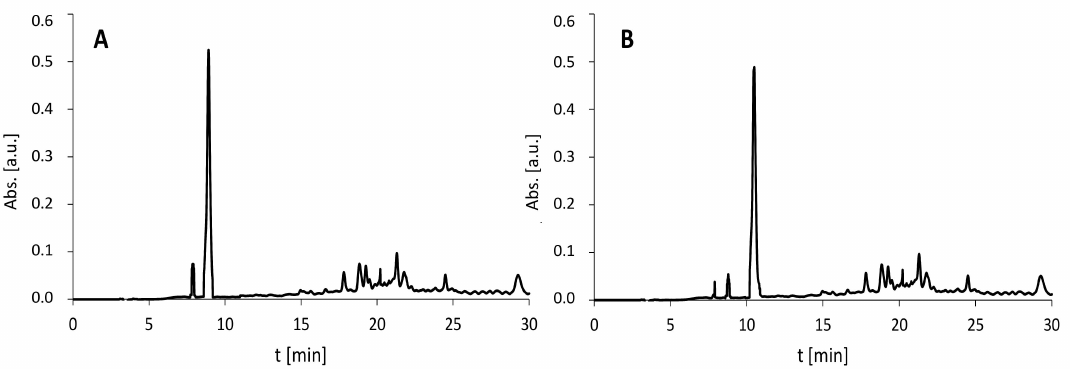
Figure 9. HPLC chromatograms (detection at 210 nm) of crude peptide 1 ( A ) after classical AMIA coupling to the DVYT-peptidyl resin and after ultrasonic-agitated coupling ( B ) within 15 min; ( C ) 2 × 15 min and ( D ) 3 × 15 min.